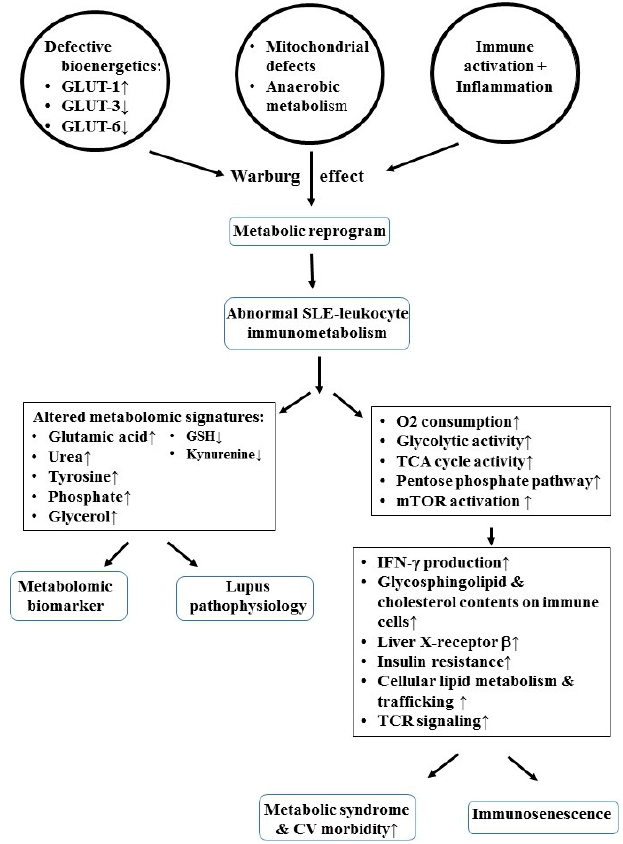
Figure 3. Defective bioenergetics/immunometabolism in association with mitochondrial dysfunctions mark the metabolomic signatures and predispose metabolic syndrome in patients with SLE. GLUT: Glucose transporter; TCA: Tricarboxylic acid; mTOR: Mammalian target of rapamycin; IFN: Interferon; TCR: T cell receptor; CV: cardiovascular.